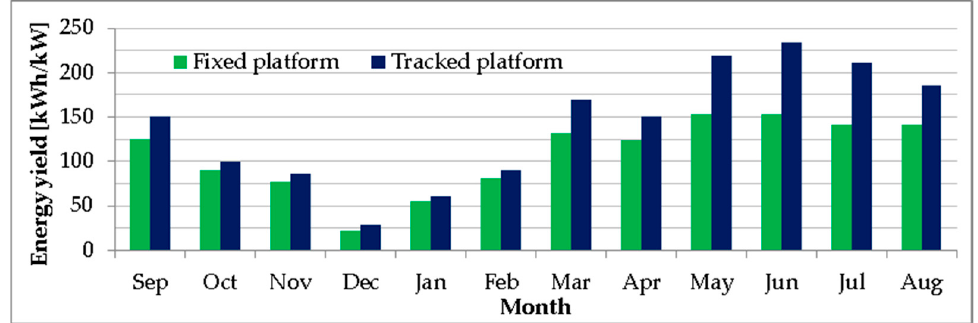
Figure 17. The monthly energy yield of the fixed and tracked PV platforms.